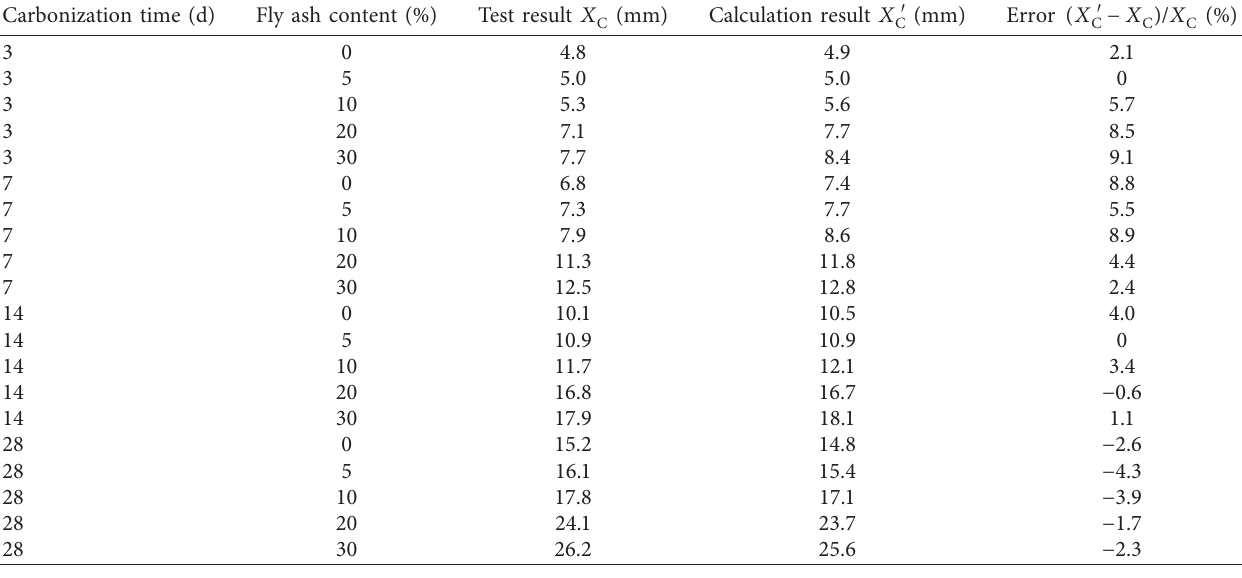
Table 6: Comparison of predicted and measured carbonization